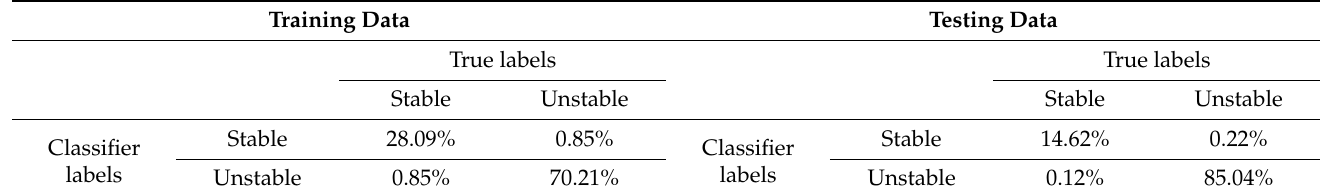
Table 4. ANN confusion matrices on training and testing data.